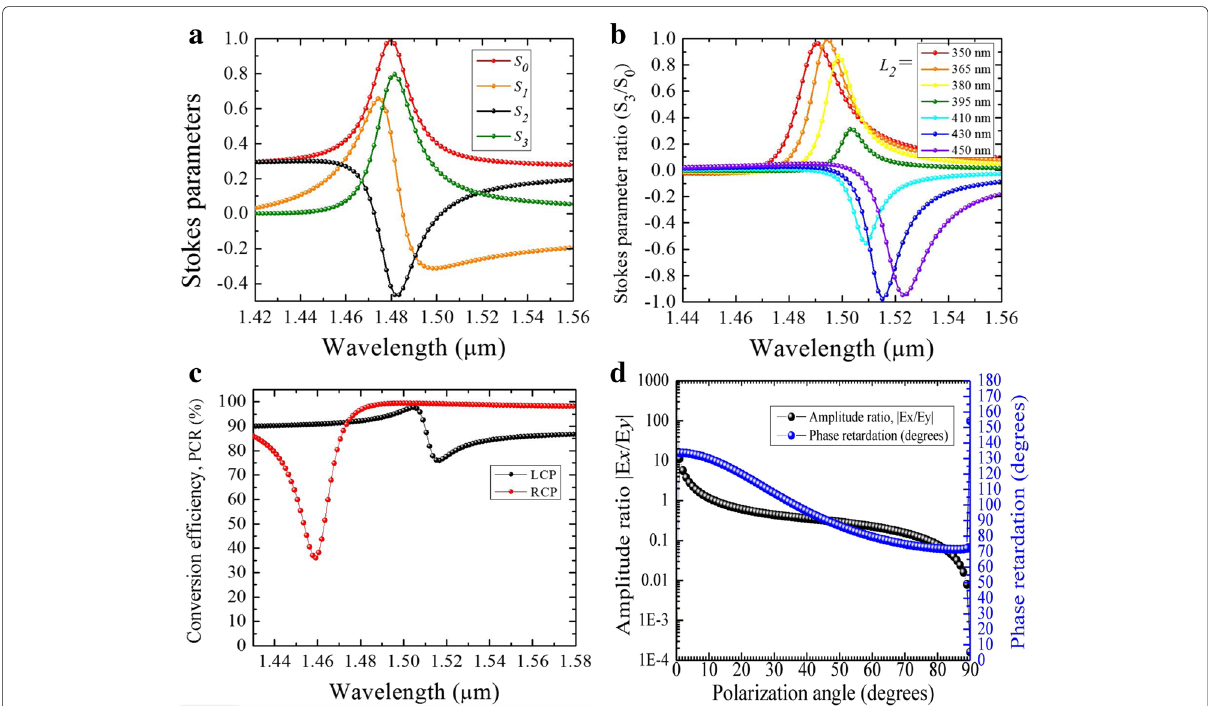
Fig. 5 a Stokes parameters variation against the wavelength for an incident angle of polarization α = 48 ◦ . b . Stokes parameter ratio ( S 3 / S 0 ) variation as a function of L 2 at α stated in a , c polarization conversion ratio calculated for an incident linearly polarized light. d . Ratio of amplitudes and phase difference at the wavelength λ = 1.5 μ m as a function of polarization angle